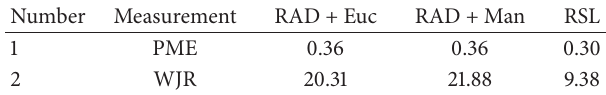
Table 3: Performance for path A under pattern a (64s).